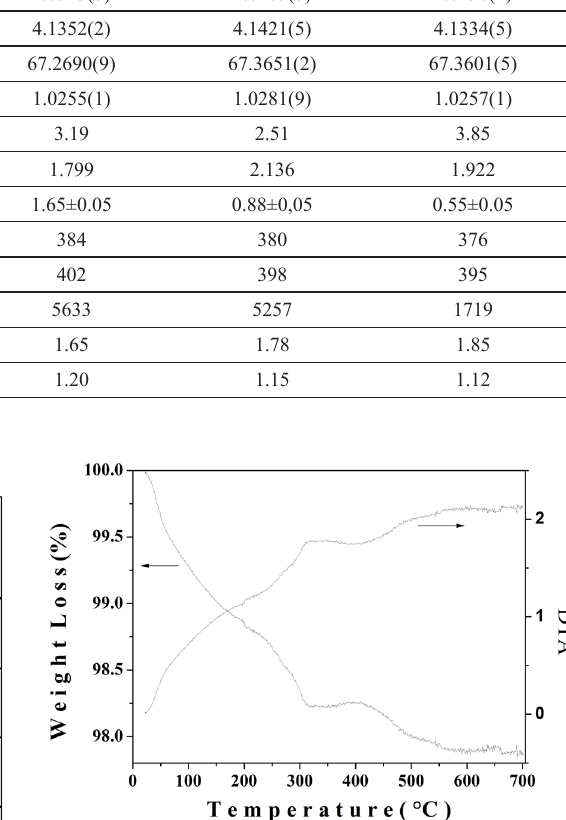
Figure 3. TGA and DTA measurements of PZT52/48